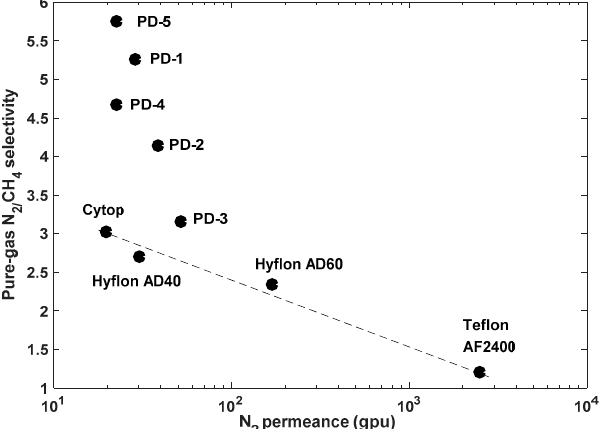
Figure 13. Pure-gas N 2 /CH 4 selectivity as a function of N 2 permeance for various perfluorinated polymer membranes. All data measured at 22 °C, 50 psig feed pressure and 0 psig permeate pressure. PD-1: PFMMD- co -PFMD 40:60 mol%; PD-2: PFMMD- co -PFMD 50:50 mol%; PD-3: PFMMD- co -PFMD 75:25 mol%; PD-4: poly(PFMMD- co -CTFE) 63:37 mol%; and PD-5: poly(PFMMD- co -CTFE) 50:50 mol%.